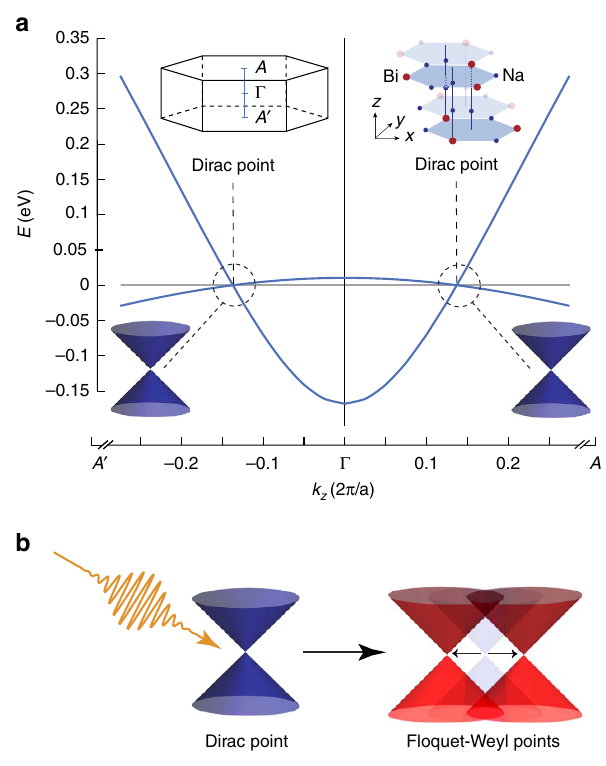
Figure 1 | Laser-induced Floquet–Weyl semimetal. ( a ) With intact time- reversal symmetry, doubly degenerate 3D Dirac cones exists at two Dirac points in Na 3 Bi. Shown are the Dirac bands along a section of the A 0 (cid:5) G (cid:5) A path through the Brillouin zone, see left inset. The right inset shows the crystal structure of Na 3 Bi. ( b ) Breaking time-reversal symmetry with circularly polarized light splits each Dirac cone into a pair of Floquet– Weyl